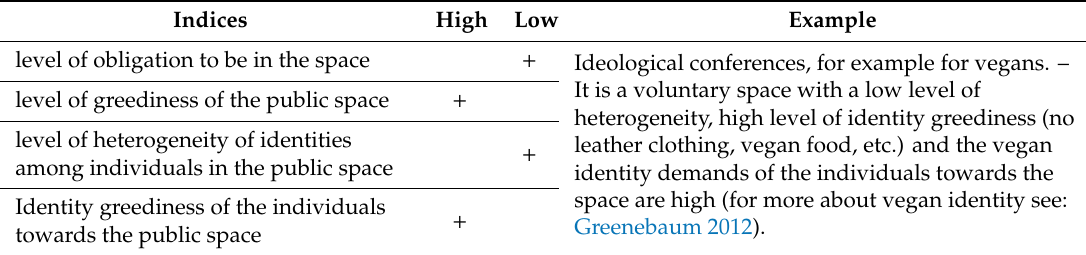
Table A14. Low potential confrontation.